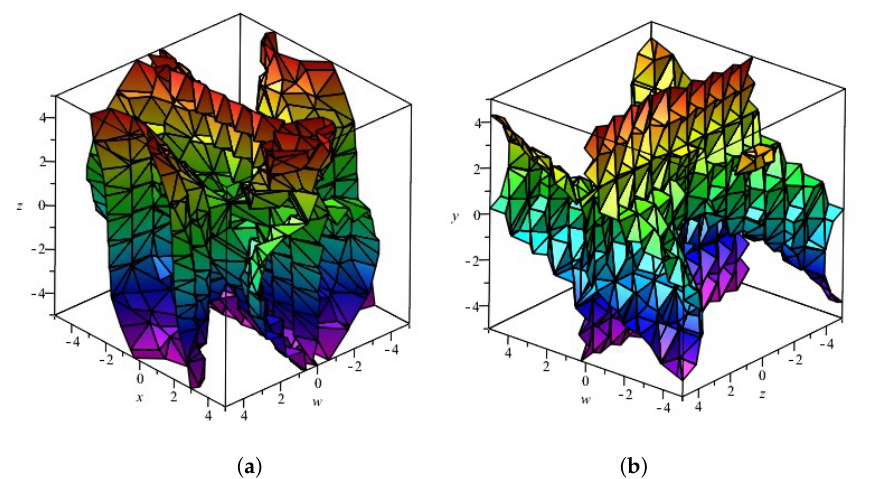
Figure 3. Projection in R 3 of a Henneberg algebraic surface. ( a ): H 4,2 ( x , z , w ) = 0; ( b ): H 4,2 ( y , z , w ) =